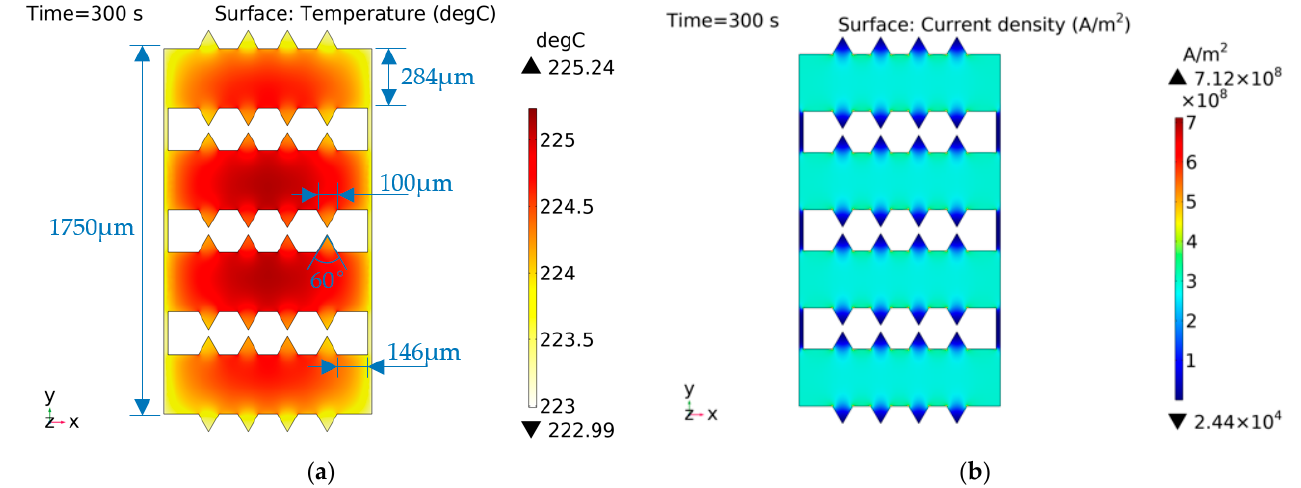
Figure 17. Characteristic distribution of shape C with a constant current (1 A) excitation. ( a ) Temperature distribution; ( b ) current density distribution.